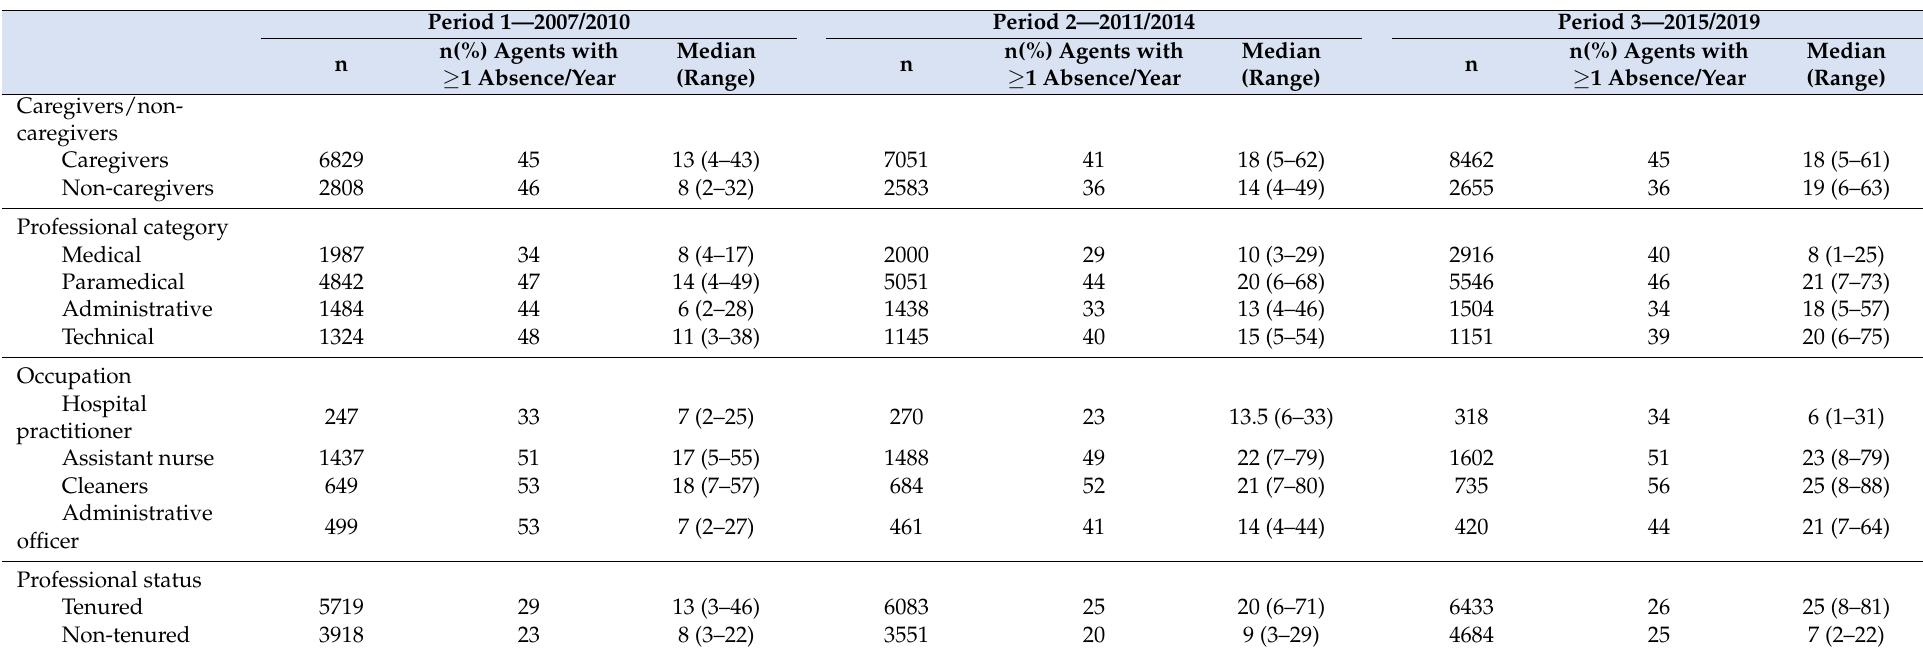
Table 2. Study of compressible absences by period and by professional and sociodemographic